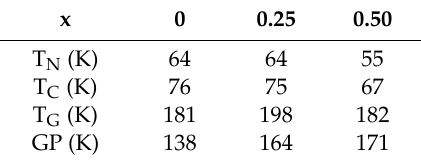
Figure 6. AC magnetic susceptibility against temperature curves for Nd 1 − x Bi x MnO 3. Table 3. Parameters obtained from AC magnetic susceptibility studies of Nd 1 − x Bi x MnO 3